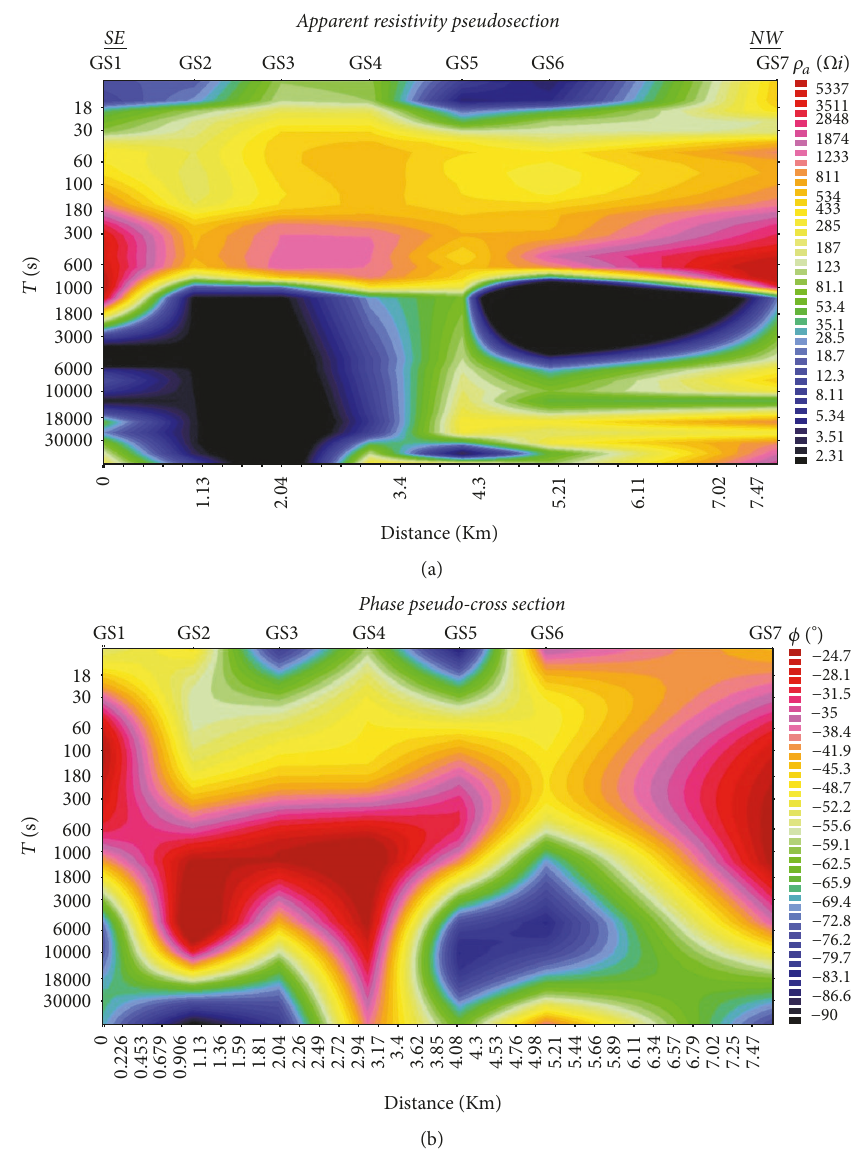
Figure 11: Apparent resistivity (a) and phase (b) pseudosection of Garga Sarali